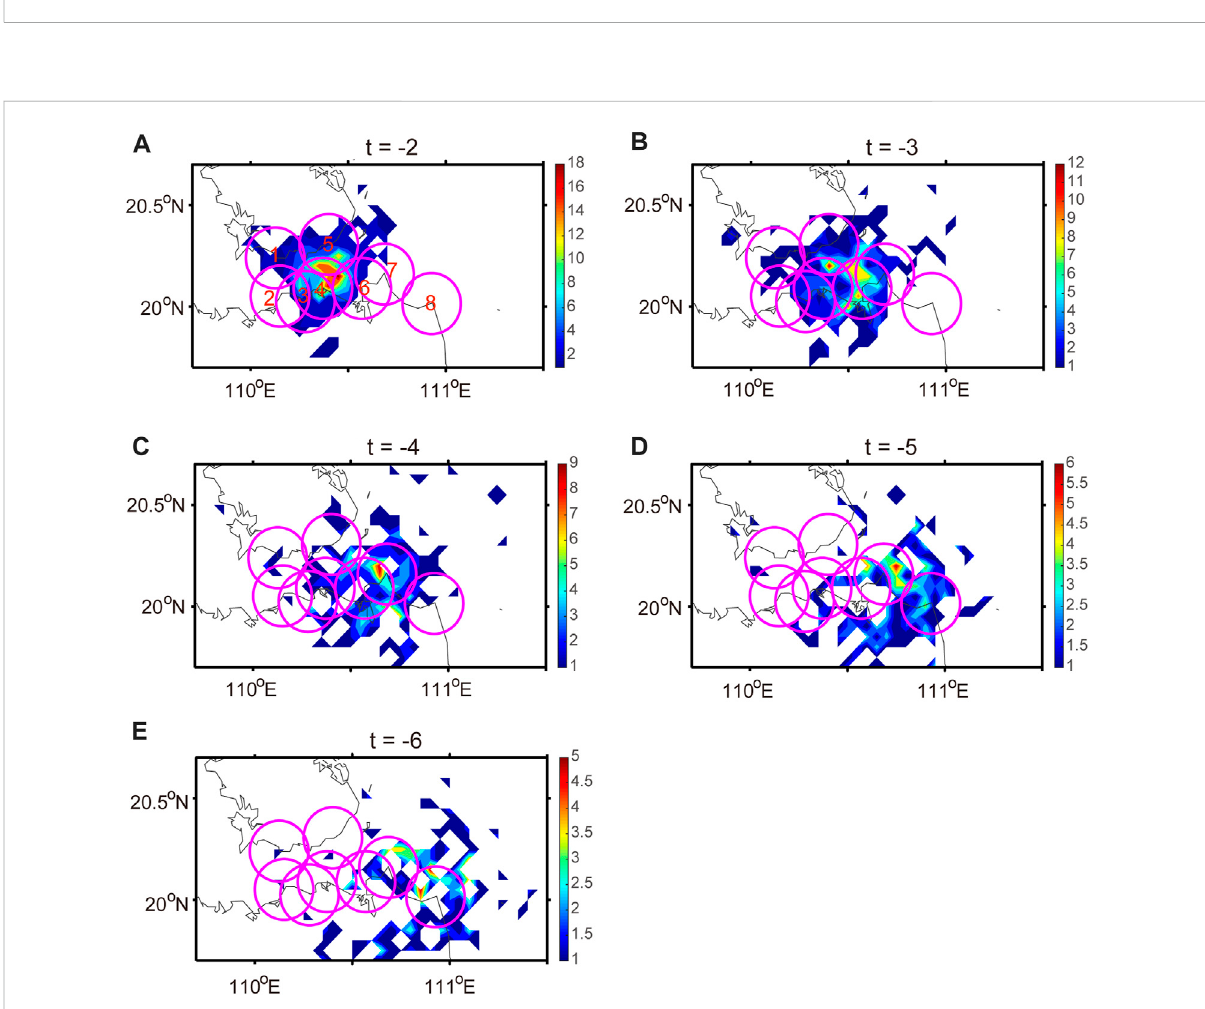
FIGURE 7 Proposed monitoring and early warning setup for Xuwen harbor. All eight visibility lidars, labeled and circled, are on the coast. Shading is the hourly backward-trajectoryfrequencydistribution from (A) t= − 2 hto (E) t= − 6 h(indicate theadvance time inhours)for Xuwen harbor. Pinkcircles are the effective radius of lidar (15 km). Positions 1 – 3 are built, positions 4-8 are proposed visibility